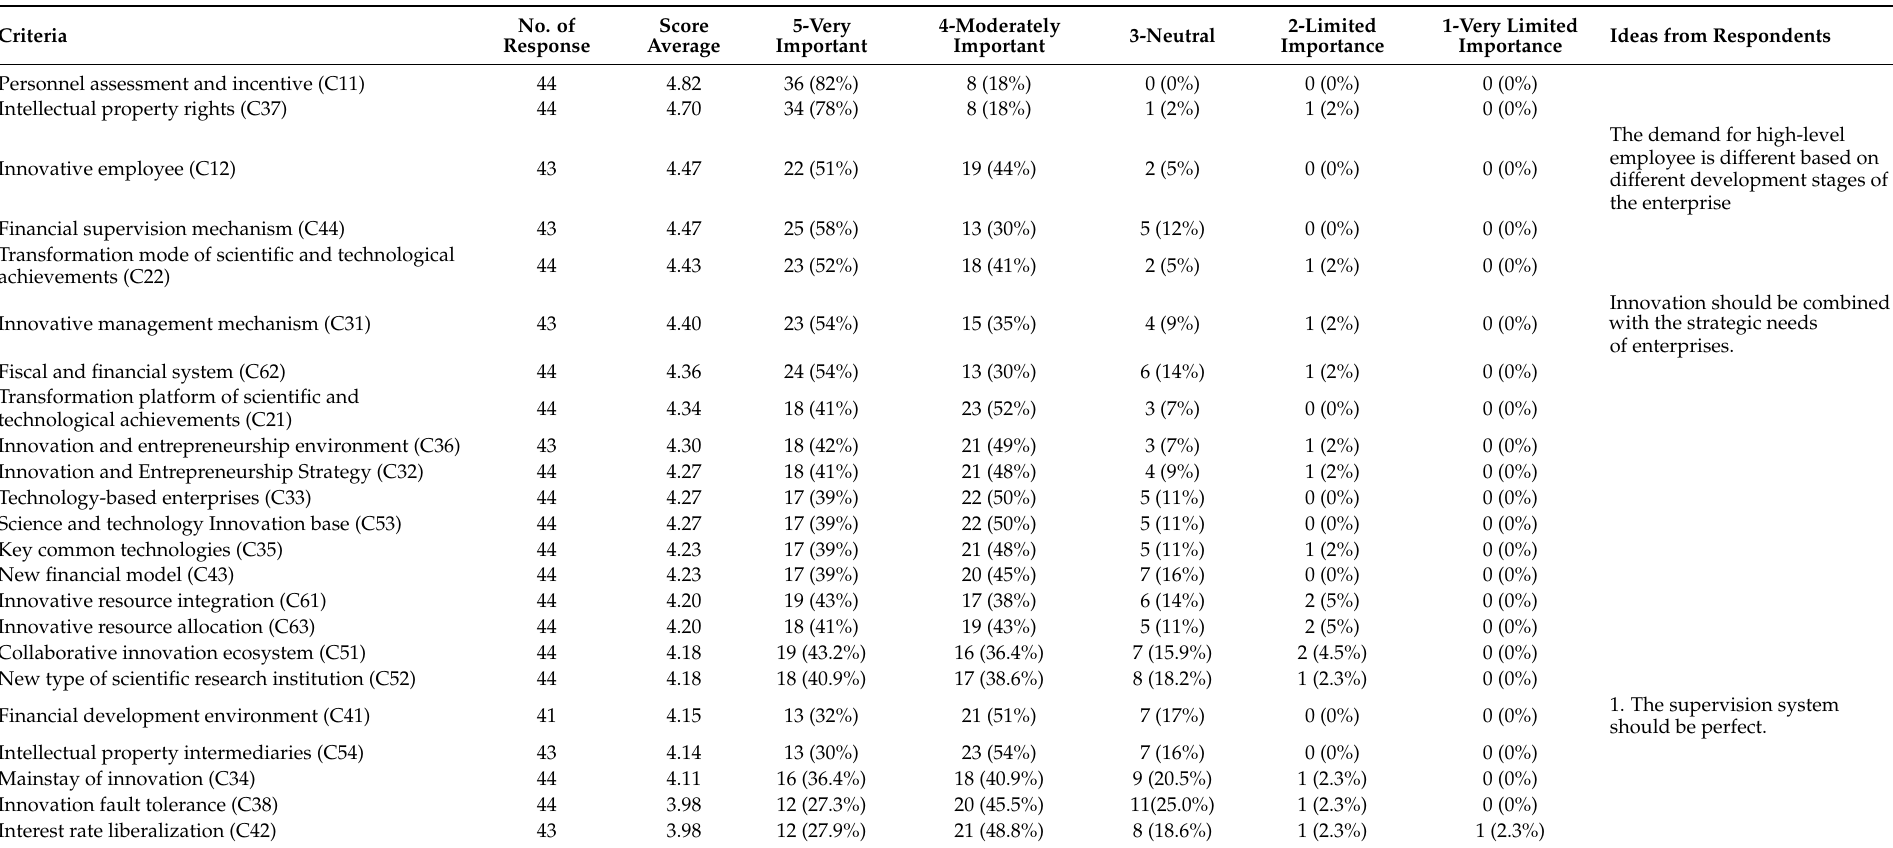
Table 4. Results of the first-round survey of modified Delphi